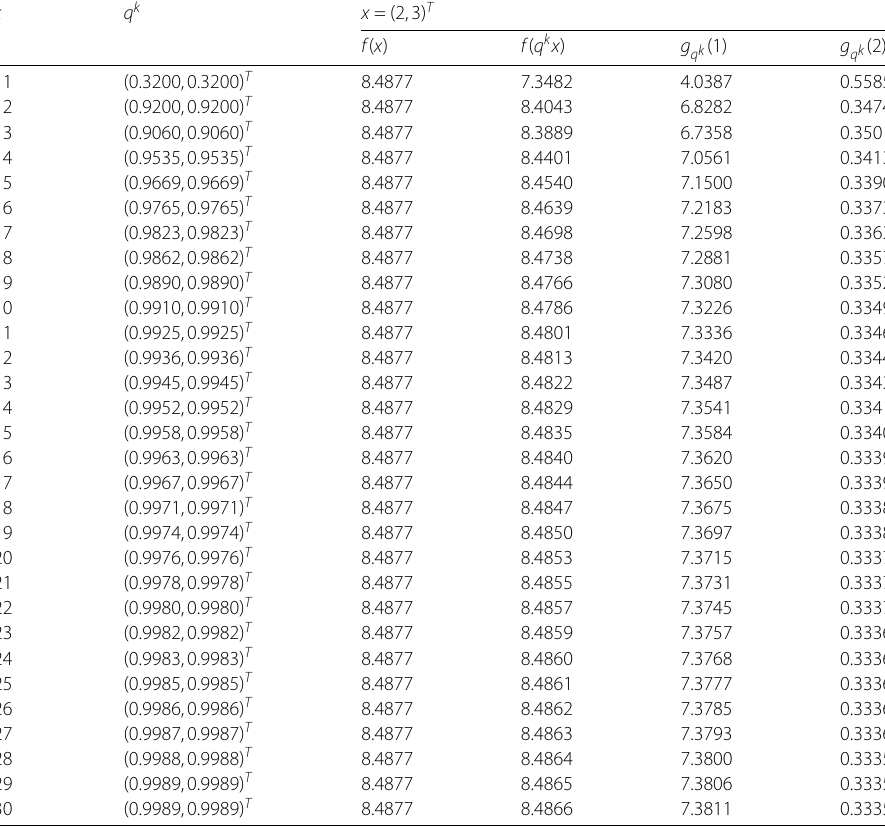
Table 1 Computational details of Example 2 for sequence { q k